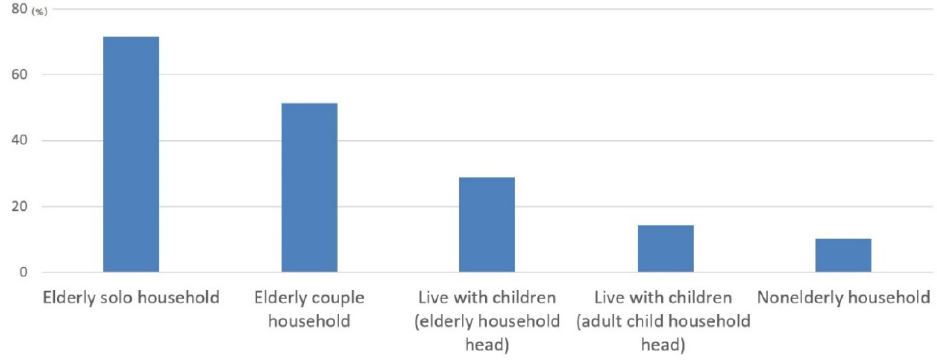
Figure 6. Poverty rate by household type (2016). Source: Korea Statics [26].